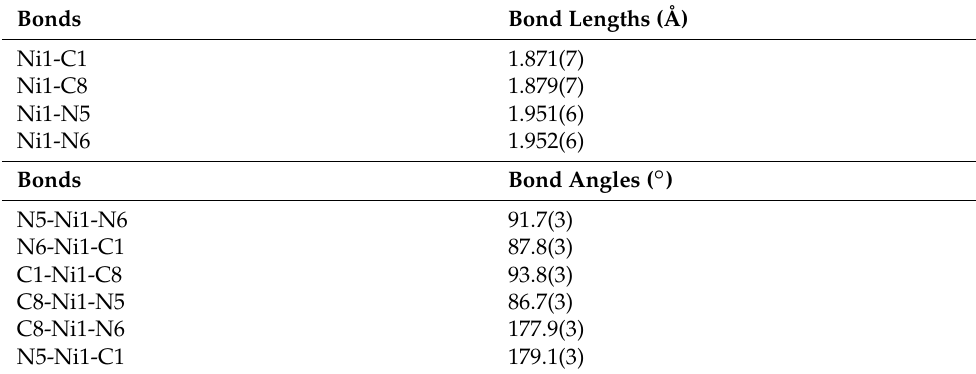
Figure 1. ( a ) and ( b ) ball and stick representation of the crystal structures 3 in different orientations. Hydrogen atoms, methanol, and hexafluorophosphates are omitted for clarity. Table 1. Selected bond lengths and (Å) bond angles (°) for 3 .